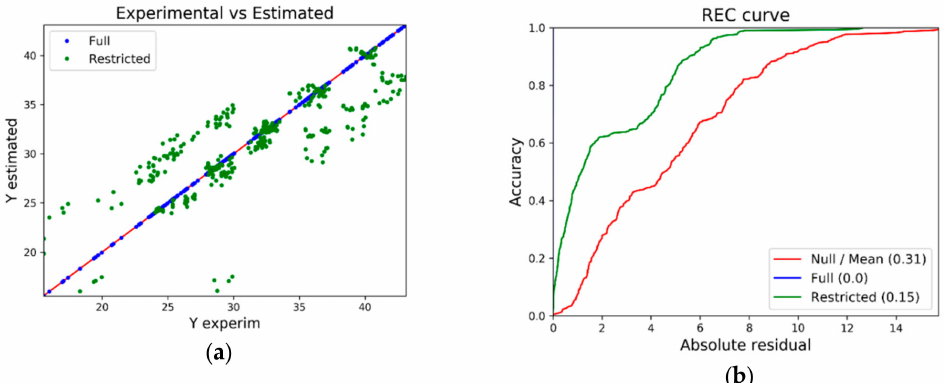
Figure 11. Results of the Heating load 2_floors problem for the full and restricted models with the parameter selection h = ω = 0.02. ( a ) Estimated vs experimental values; ( b ) REC curve for the full, restricted, and null (mean) models.